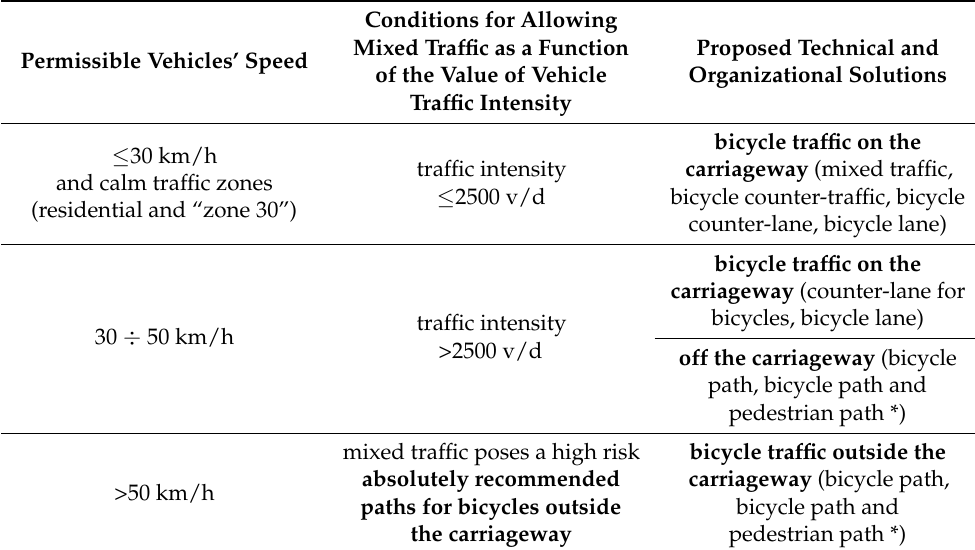
Table 1. Recommended criteria for the segregation of bicycles and other vehicles